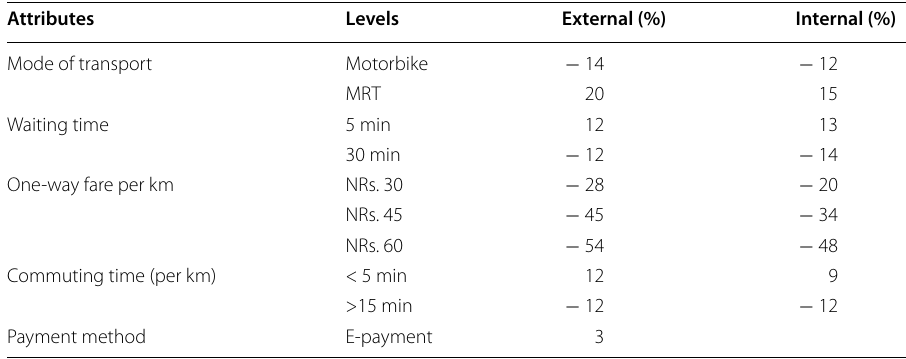
Table 3 Comparative AMCE results of external probability and internal probability Attributes Levels Mode of